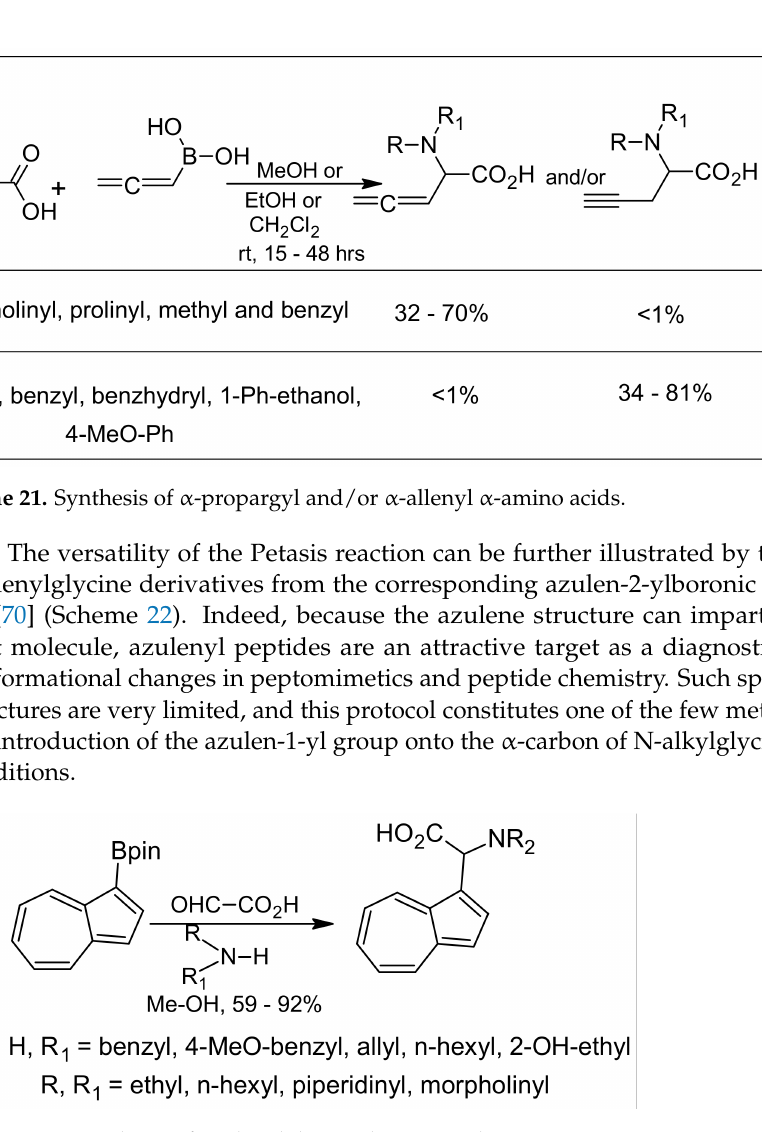
Scheme 22. Synthesis of azulenylglycine derivatives by Petasis